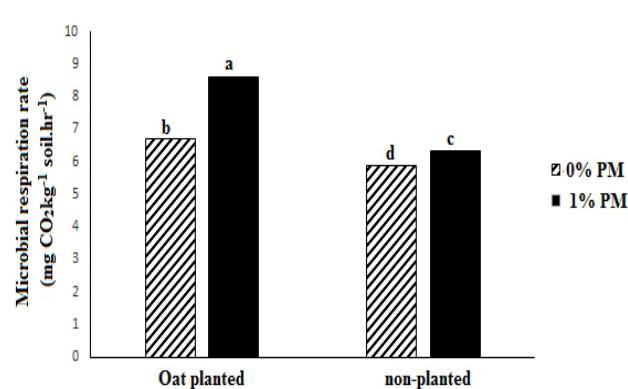
Fig. 2. Comparison of mean microbial respiration rate in PM-treated soil in planted and unplanted soils Note: Mean values followed by the same letters are not significantly different (P≤0.05) according to Duncan’s multiple range